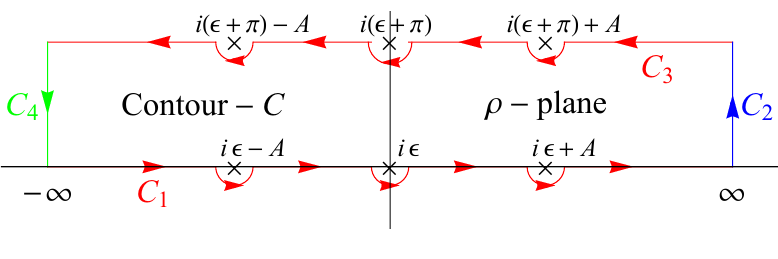
Figure 1 . Contour C for I D,n,α